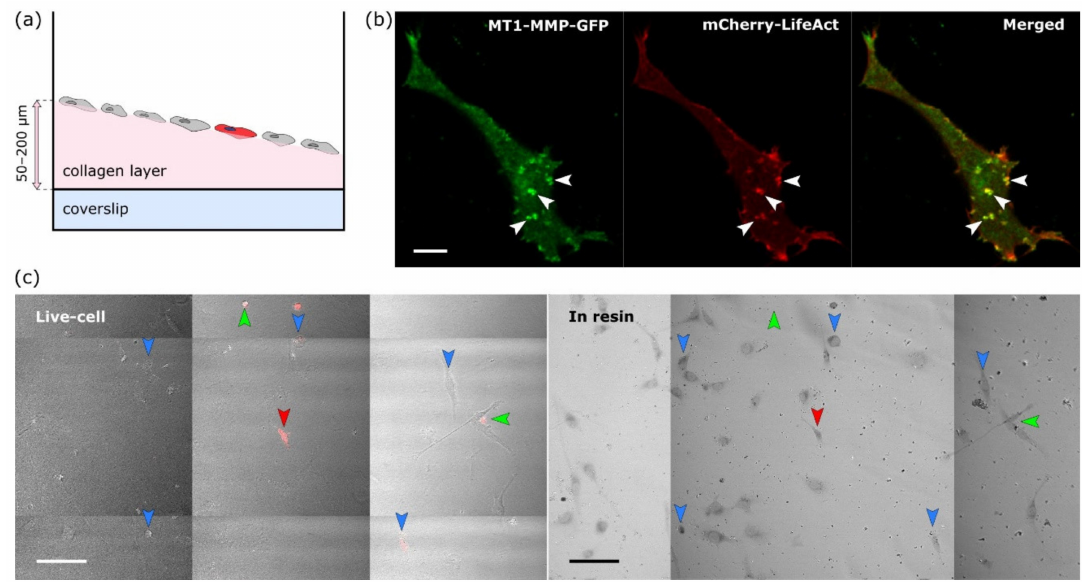
Figure 2. Live-cell imaging and resin embedding. ( a ) Scheme of a single well with varying depth of collagen. Target cell is marked in red. ( b ) Single plane of a Z-stack from live-cell imaging of a HT1080 fibrosarcoma cell. Examples of successfully resolved invadopodia are marked by arrowheads. Scale bar 10 µ m. ( c ) Comparison of the overview tile scans after live-cell imaging (left) and resin embedding for EM (right). The majority of the cells (a couple of examples are marked by blue arrowheads) and the target cell (red arrowhead) were fixed successfully. Cells washed away in the process are marked by green arrowheads. Scale bars 100 µ